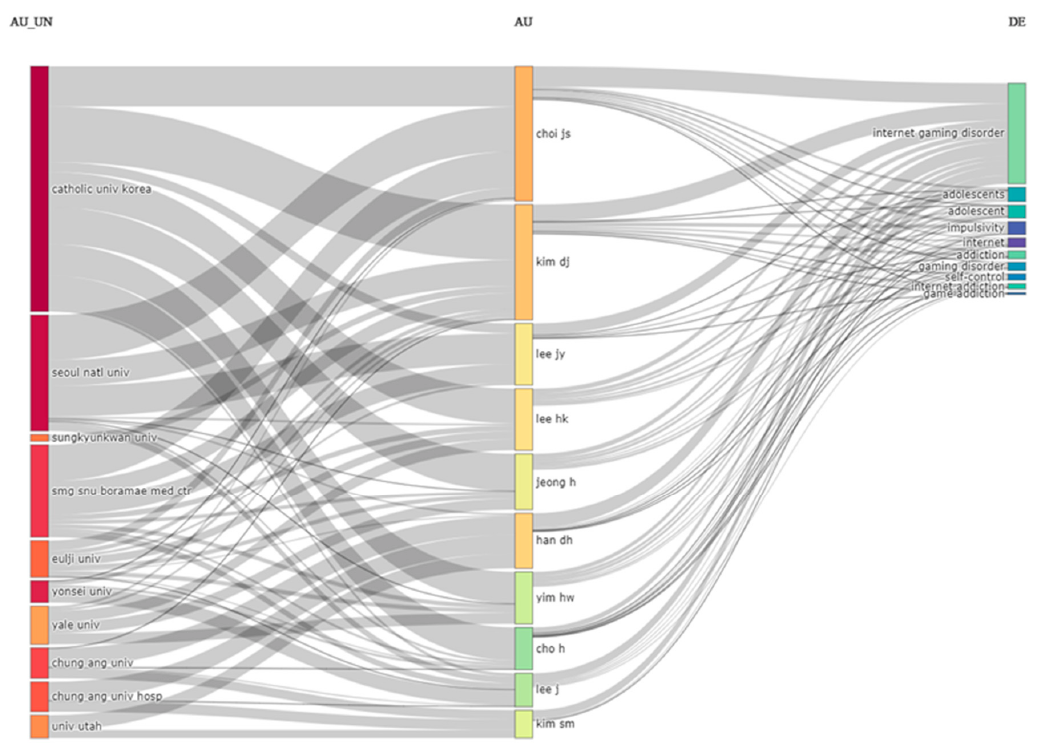
Figure 3. Three-field plot of authors, their affiliations, and keywords. Footnote: Each of the categories is limited to 10 items. The resolution of the image is limited by the software that is used for the processing of the image.